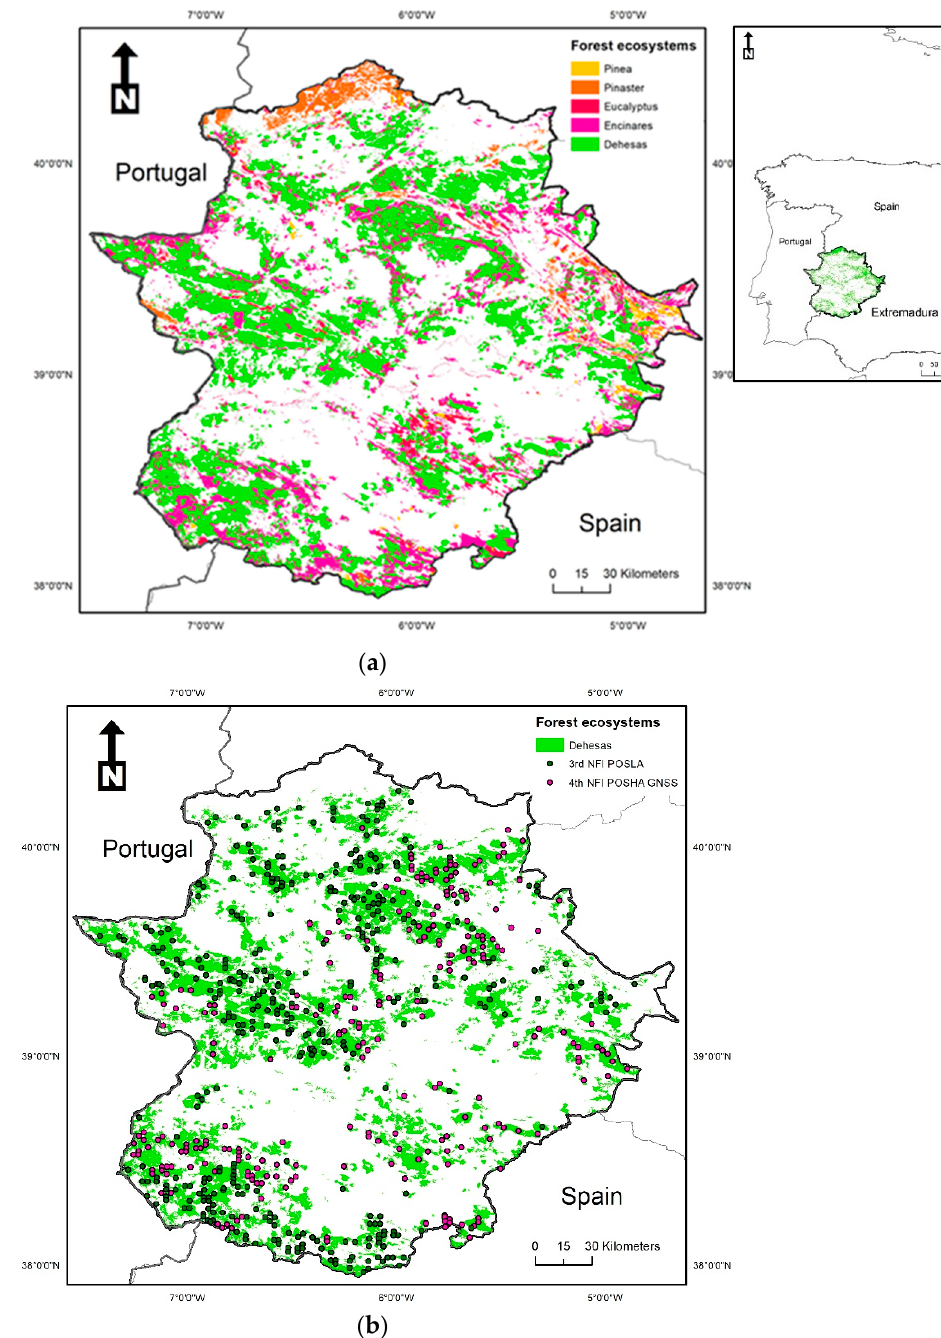
Figure 1. ( a ) Forest map of Spain for the region of Extremadura showing the five forest ecosystems assessed using the sample plot from the National Forest Inventory (NFI). ( b ) Spatial arrangement of NFI samples for Dehesa forest ecosystems, distinguishing between coordinates measured in the 4th NFI using Global Navigation Satellite Systems ( POS HA ) and in the 3rd round of the NFI using traditional positioning methods ( POS LA ).